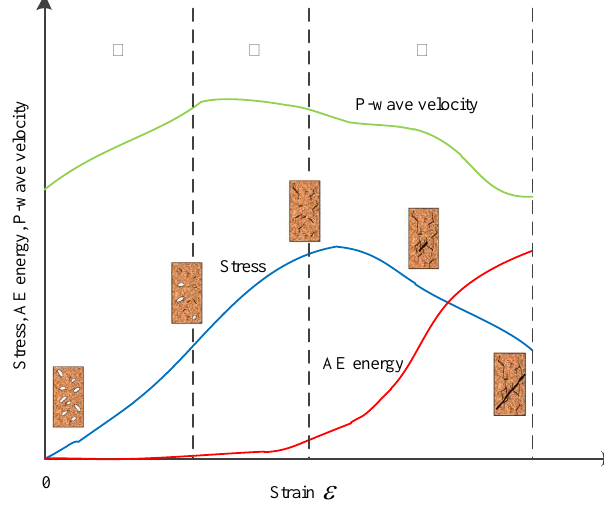
Figure 13. AE event evolution charateristics of coal samples during loading.